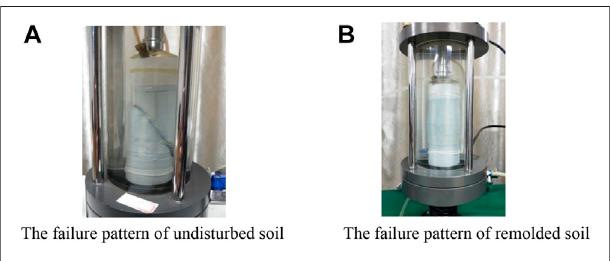
FIGURE 2 | The failure patters of samples. (A) The failure pattern of undisturbed soil (B) The failure pattern of remolded soil.